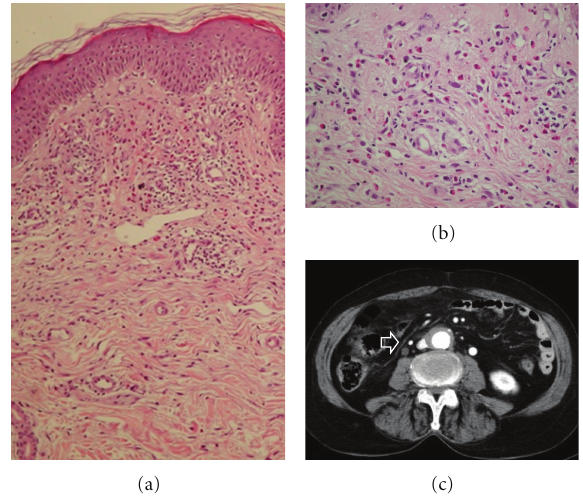
Figure 2: Chronic periaortitis presenting as recurrent cutaneous eosinophilic vasculitis (RCEV). (a) Skin biopsy showing under a focally slight spongiotic epidermis edema and moderately dense perivascular and interstitial inflammatory cell infiltrates confined to the upper dermis (hematoxylin & eosin; × 40). (b) Histopathol- ogy of skin lesion (detail) showing the inflammatory infiltrate consisting of lymphocytes, monocytes, and plentiful eosinophils. Altered vessels with endothelial swelling, intraluminal fibrin, a few eosinophils within vessel walls, and eosinophilic dust around them were featured. Leukocytoclasis or overt vascular necrosis was not seen (hematoxylin & eosin; × 160). (c) Contrast-enhanced CT scan (portal phase) revealed a mantle of a soft-tissue mass enveloping the aorta, consistent with chronic periaortitis (retroperitoneal fibrosis). Typically, the aorta is encased but not displaced by this process. Arrow: right